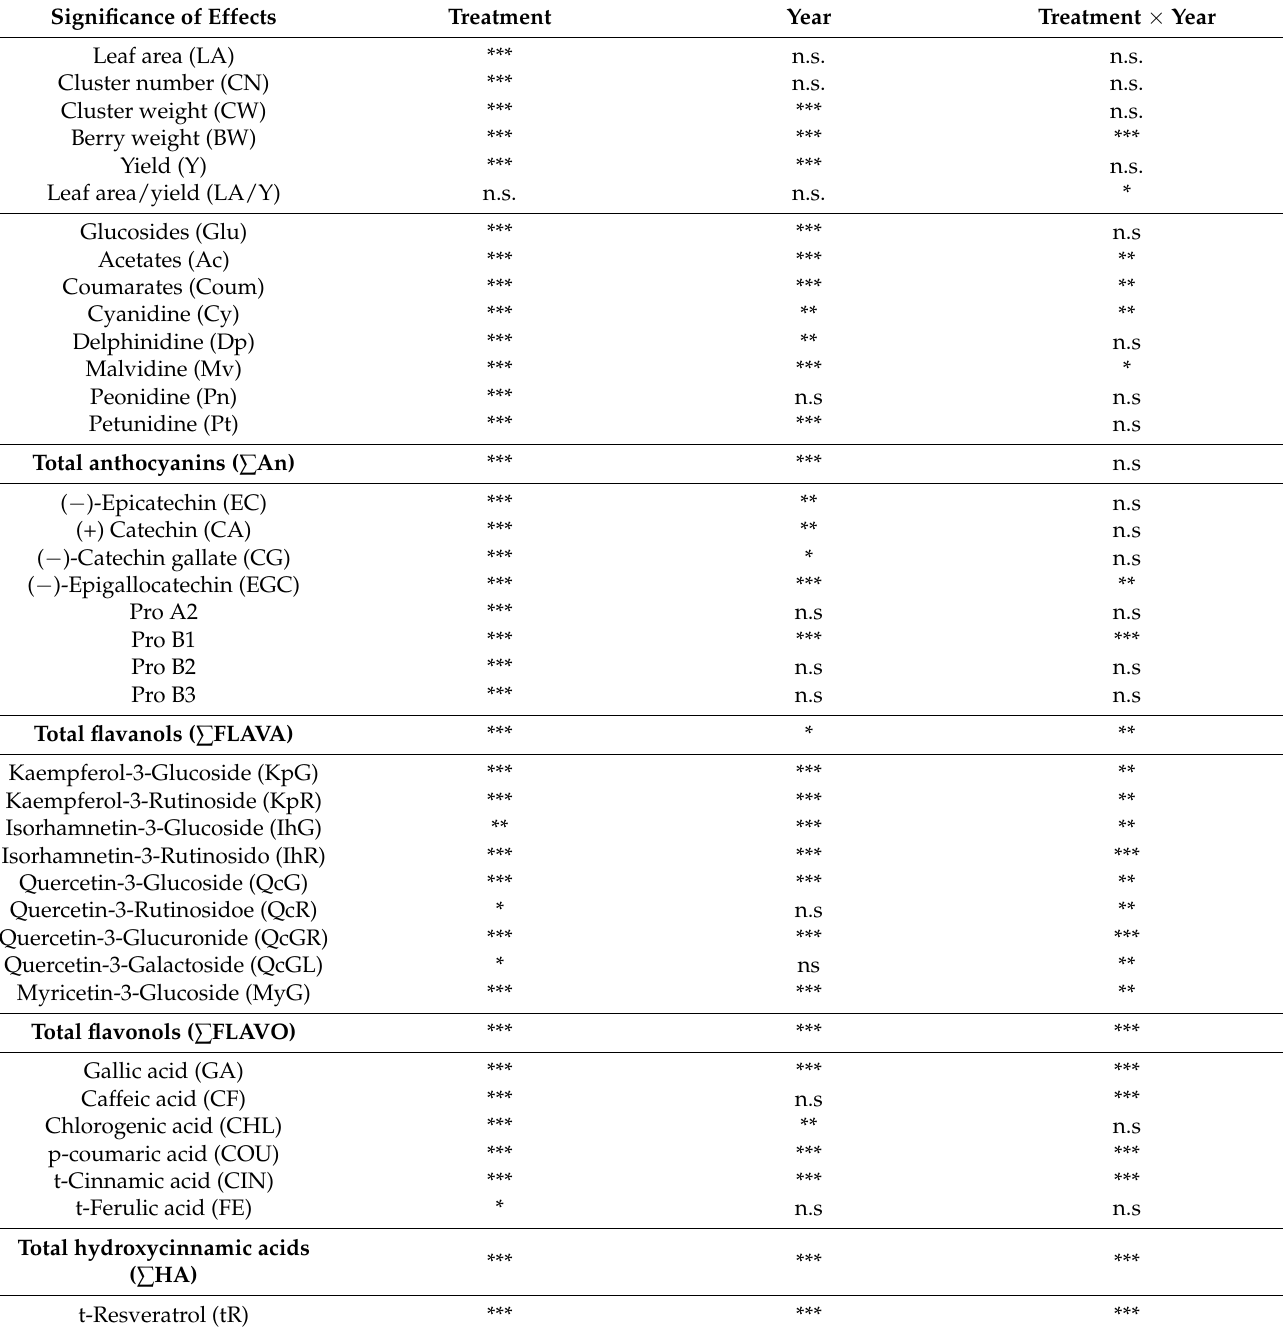
Table 2. Effect of irrigation (treatment) and experimental season (year) and their interactions on values of vegetative, agronomic and polyphenolic content of cv. Tempranillo grapes at harvest. Significance of